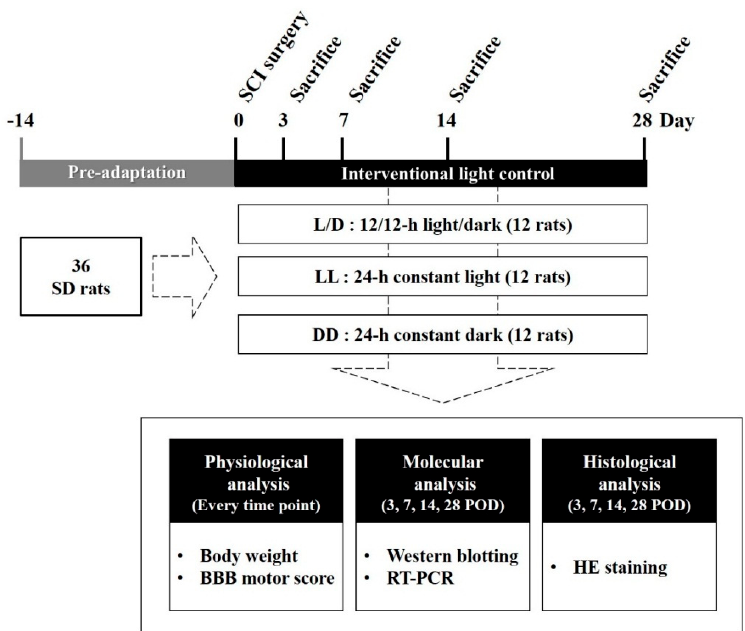
Figure 1. Experimental scheme of the study. Experimental animals were randomly divided into 3 groups: 12/12-h light/dark (L/D), 24-h constant light (LL), and 24-h constant dark (DD). The animals were sacrificed 3, 7, 14, and 28 days after injury for further analyses.